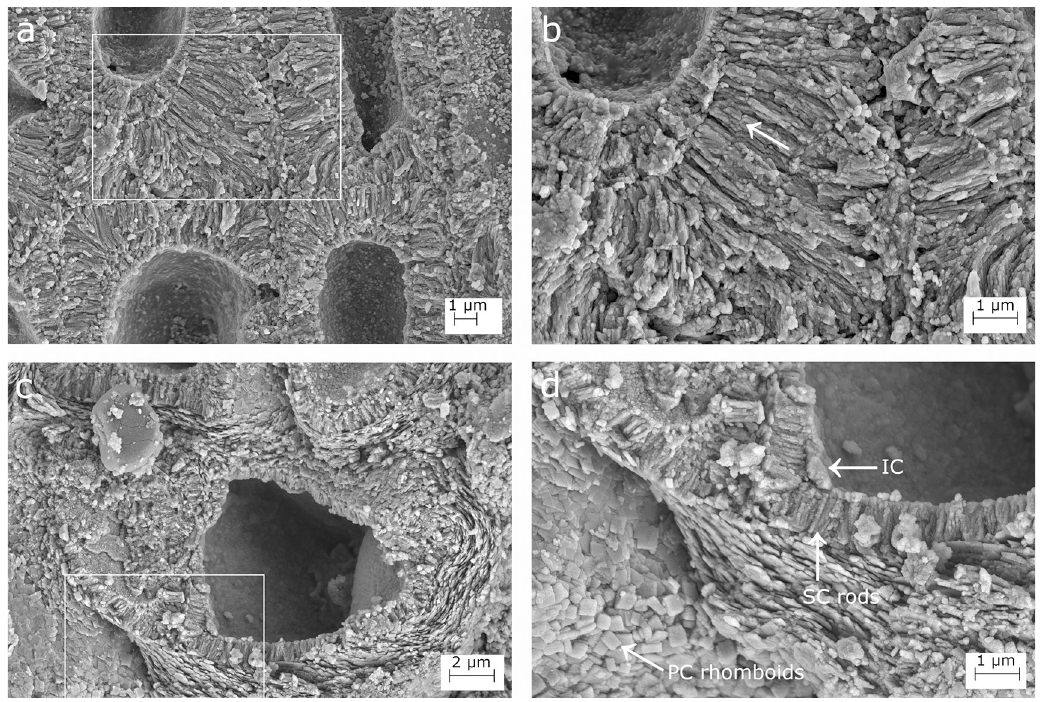
Fig 4. SEM images showing longitudinal sections of the calcified thallus in Lithophyllum pseudoracemus . (a) Multiple layers of secondary calcification forming the thick cell walls; (b) magnification of the inset in (a); the arrow points to the contact of two layers of SC; (c), secondary hypothallial cells in the proximity of the pore canal in Fig 3F; (d) magnification of the inset in (c) to show the rhomboidal crystallites in the hypothallial primary calcification (PC); the SC rods and the innermost calcified layer (IC).